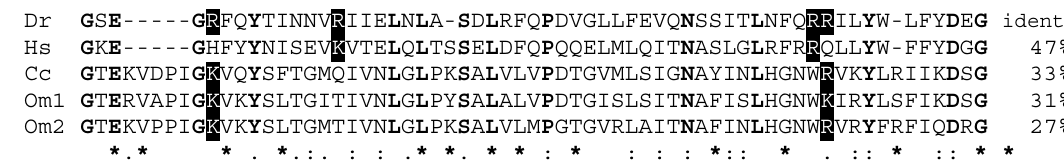
Figure 4. The first 57 N-terminus residues, deduced from CatDcDNA of zebrafish, is aligned with those of Mp ( Macroscelide sproboscideus ), Ch ( Clupeaharengus ), Rt (Rainbow trout, Oncorinchus mikissis ) and Tarku ( Takifugu rubripes, Tf). The typical motifs (signal peptide, A1 propetide, and mature protein) are indicated.